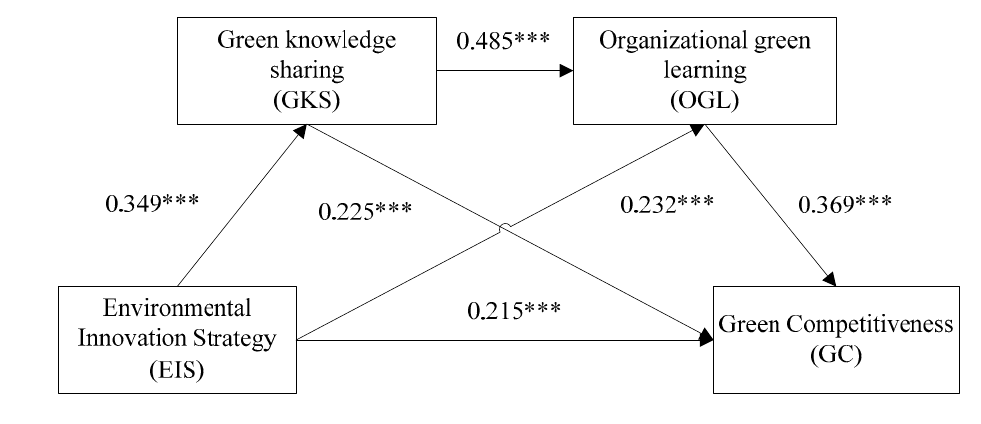
Figure 2. Results of path coefficients. Note: *** p < 0.001.